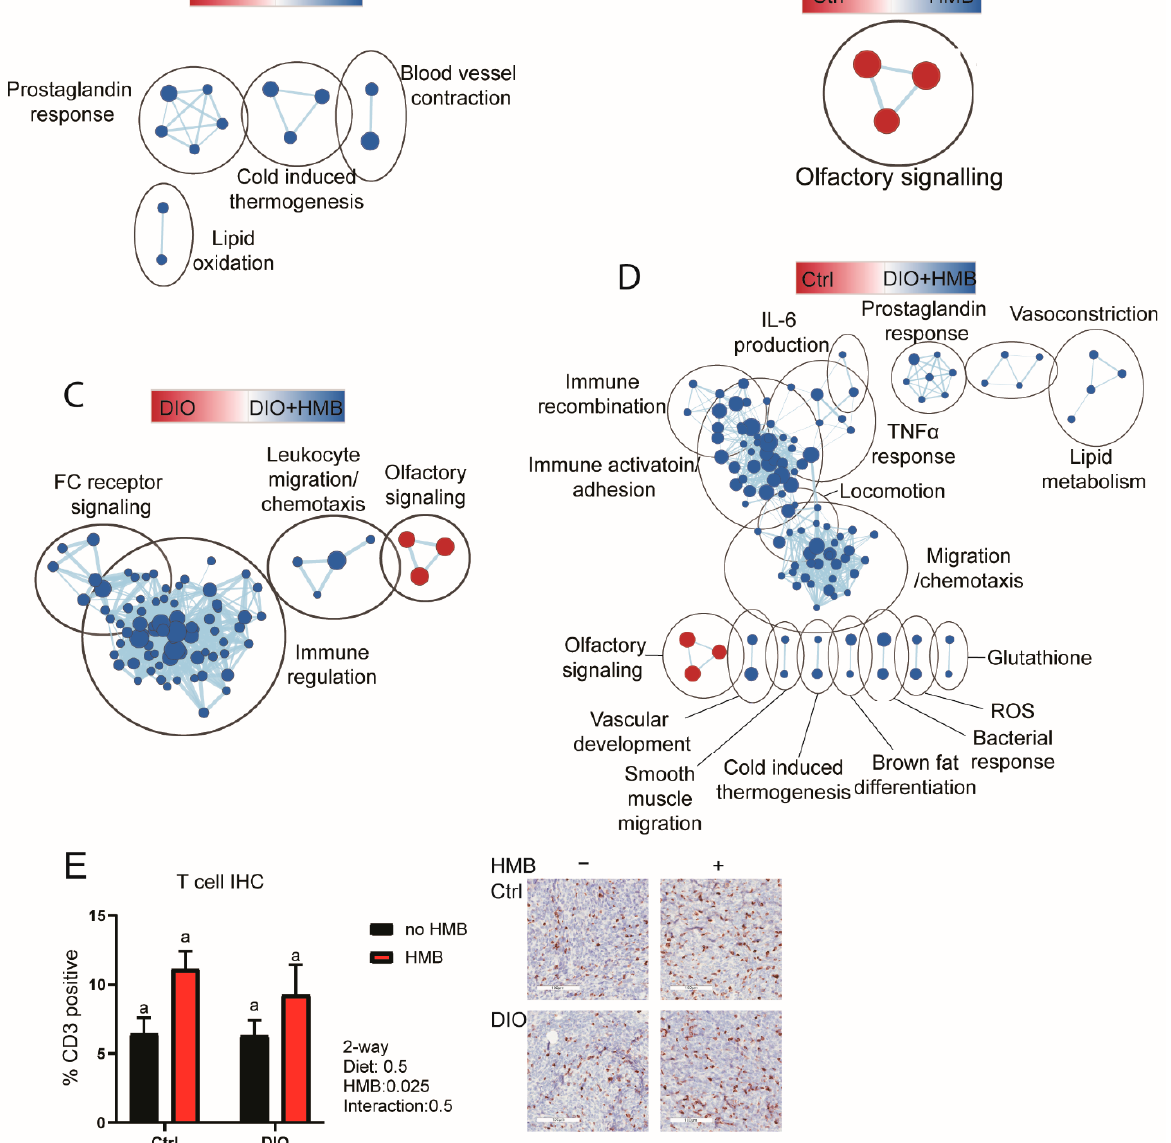
Figure 2. ( A – D ) Enrichment maps of significant GSEA GO biological processes in tumors from control and DIO mice supplemented with and without HMB. (FDRq < 0.05). Node color indicates the normalized enrichment score, node size indicates the gene set size, line weight indicates the degree of overlap, and clusters indicate the minimum 50% overlap of gene sets. ( A ) Control vs. DIO, ( B ) control vs. control + HMB, ( C ) DIO vs. DIO + HMB, ( D ) control vs. DIO + HMB ( n = 3–4/group). ( E ) T cell quantification by immunohistochemistry staining of CD3 ( n = 5–6/group). Scale bars represent 100 µm.